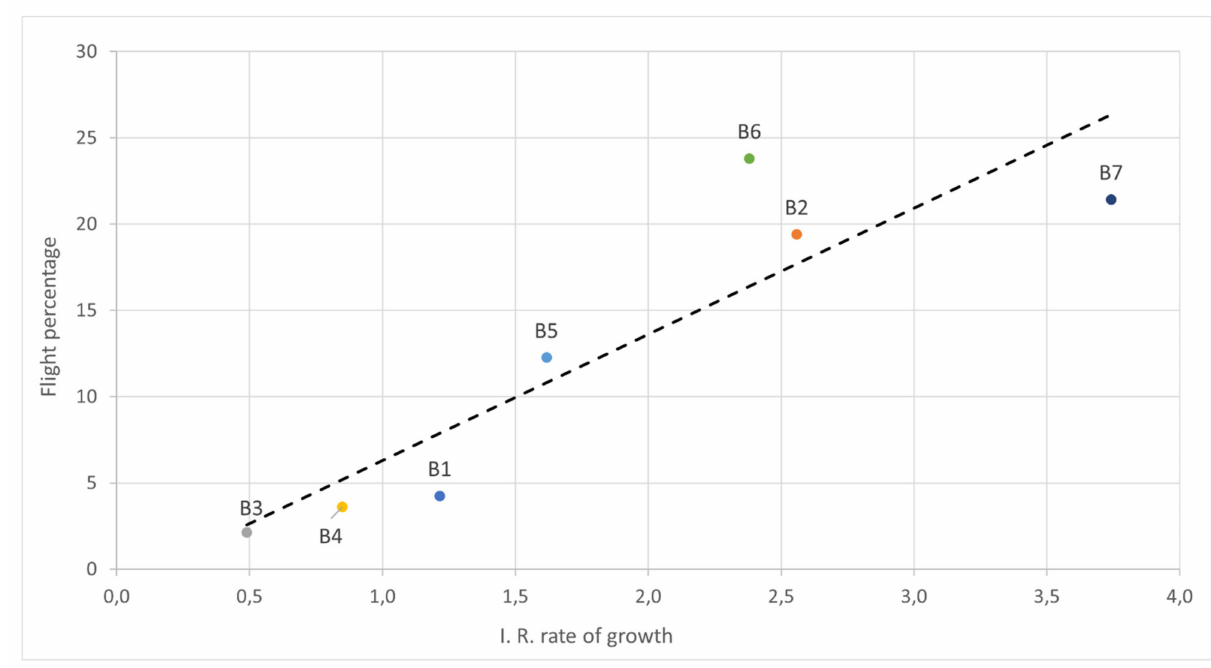
Figure 18. Competition flight percentage vs. internal resistance